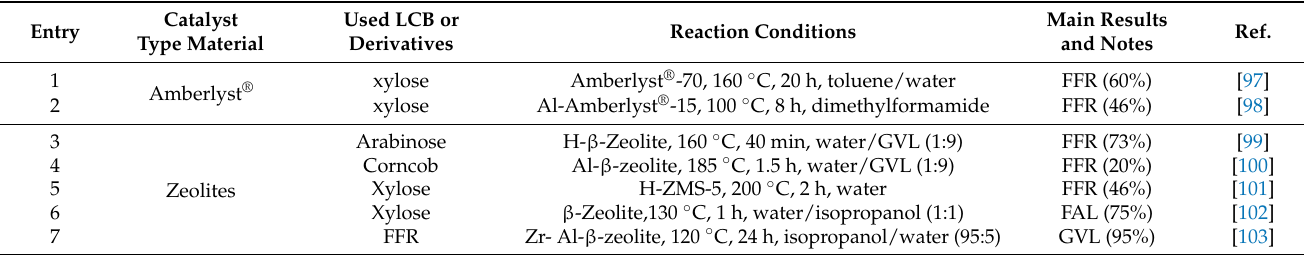
Table 4. Comparative studies on the conversion of hemicellulose-based materials to FFR and its derivatives under different reaction